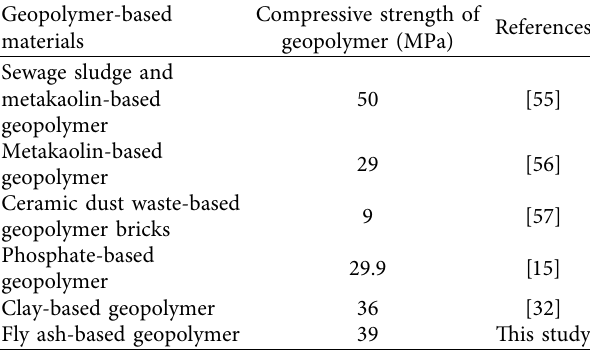
Table 4: Comparison of the compressive strength of material- based geopolymer